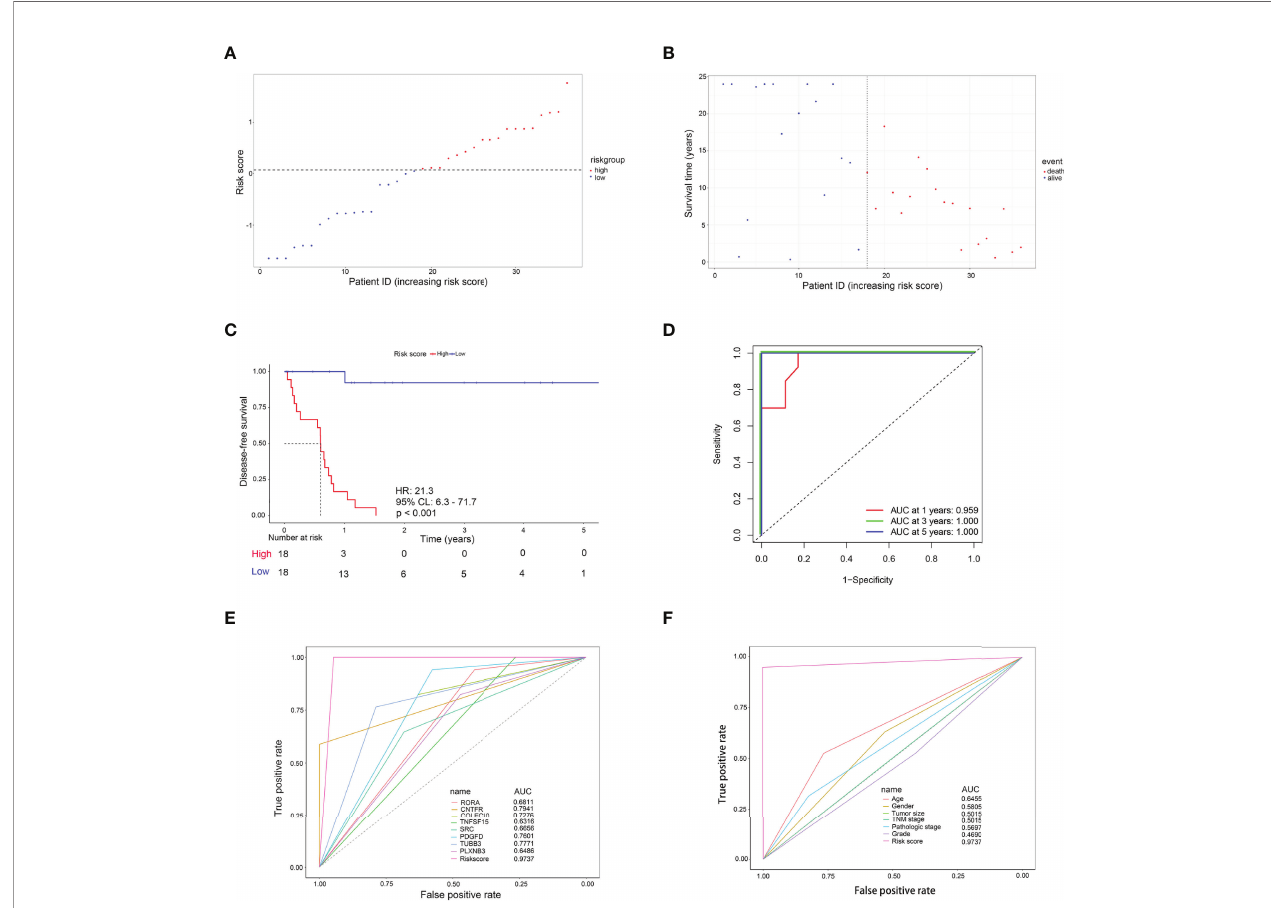
FIGURE 4 | Evaluation of the 8-IRDEGs signature for relapse in the TCGA cohort. (A) Distribution of the risk score derived from the signature. Patients are ranked according to the corresponding risk score. (B) Survival status of CCA patients in different risk subgroups. (C) The Kaplan – Meier survival curve of recurrence-free for patients between two different groups. (D) Time-dependent ROC curve at 1, 3, and 5 years. (E) Comparison of prognostic accuracy between the signature and single mRNAs. (F) Comparison of prognostic accuracy between the signature and clinical characteristics. p -values were calculated using the log-rank test. HR, hazard ratio; AUC, area under the ROC curve; RFS, recurrence-free